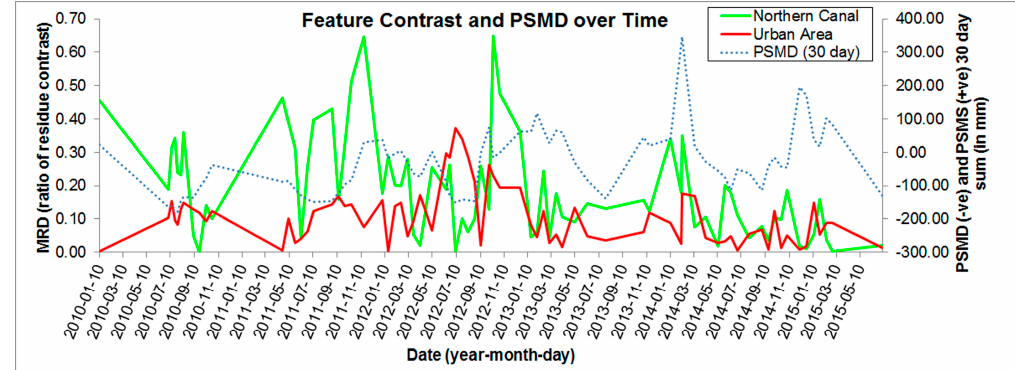
Figure 14. Subset areas used for Mean Ratio Detector (MRD) contrast analysis shown as: ( a ) green polygons, over and outside of a part of the Northern Canal residue; and ( b ) red polygons, over and outside of a part of the southern urban area residues. Polygons are overlain on the image of filtered σ 0 backscatter acquired on 16 November 2011. COSMO SkyMed data provided by the Italian Space Agency.